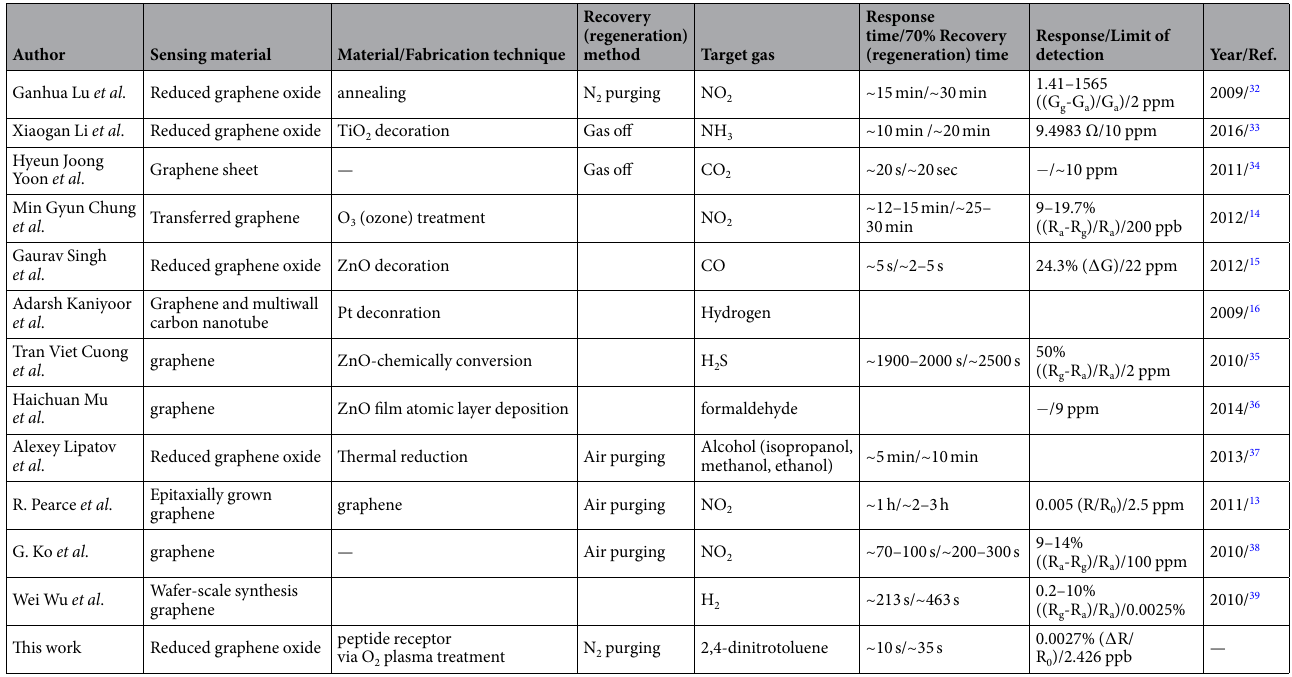
Table 1. Comparison of previously reported graphene-based gas